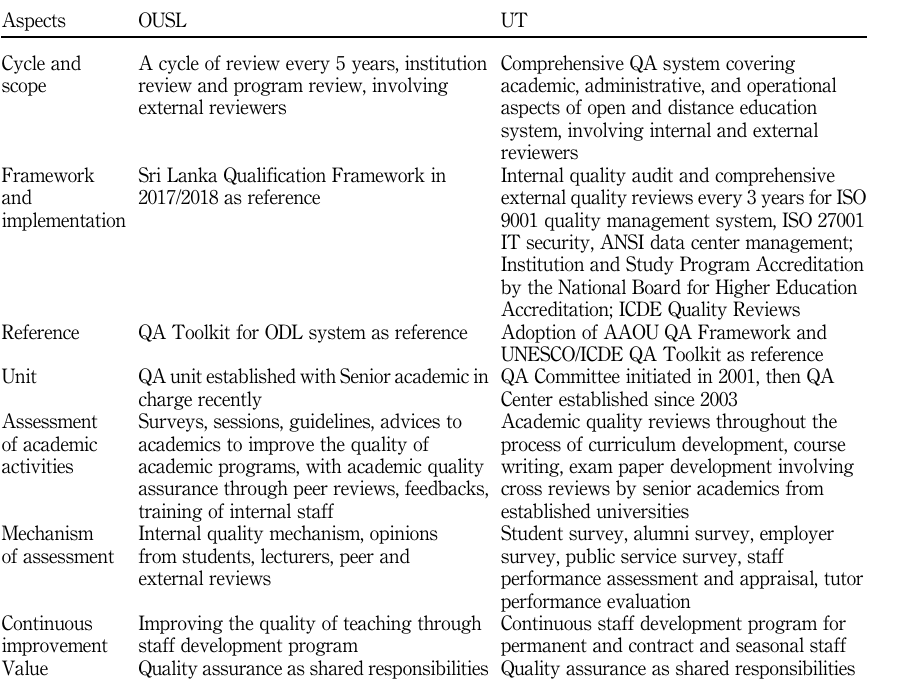
Table 19. Good practices